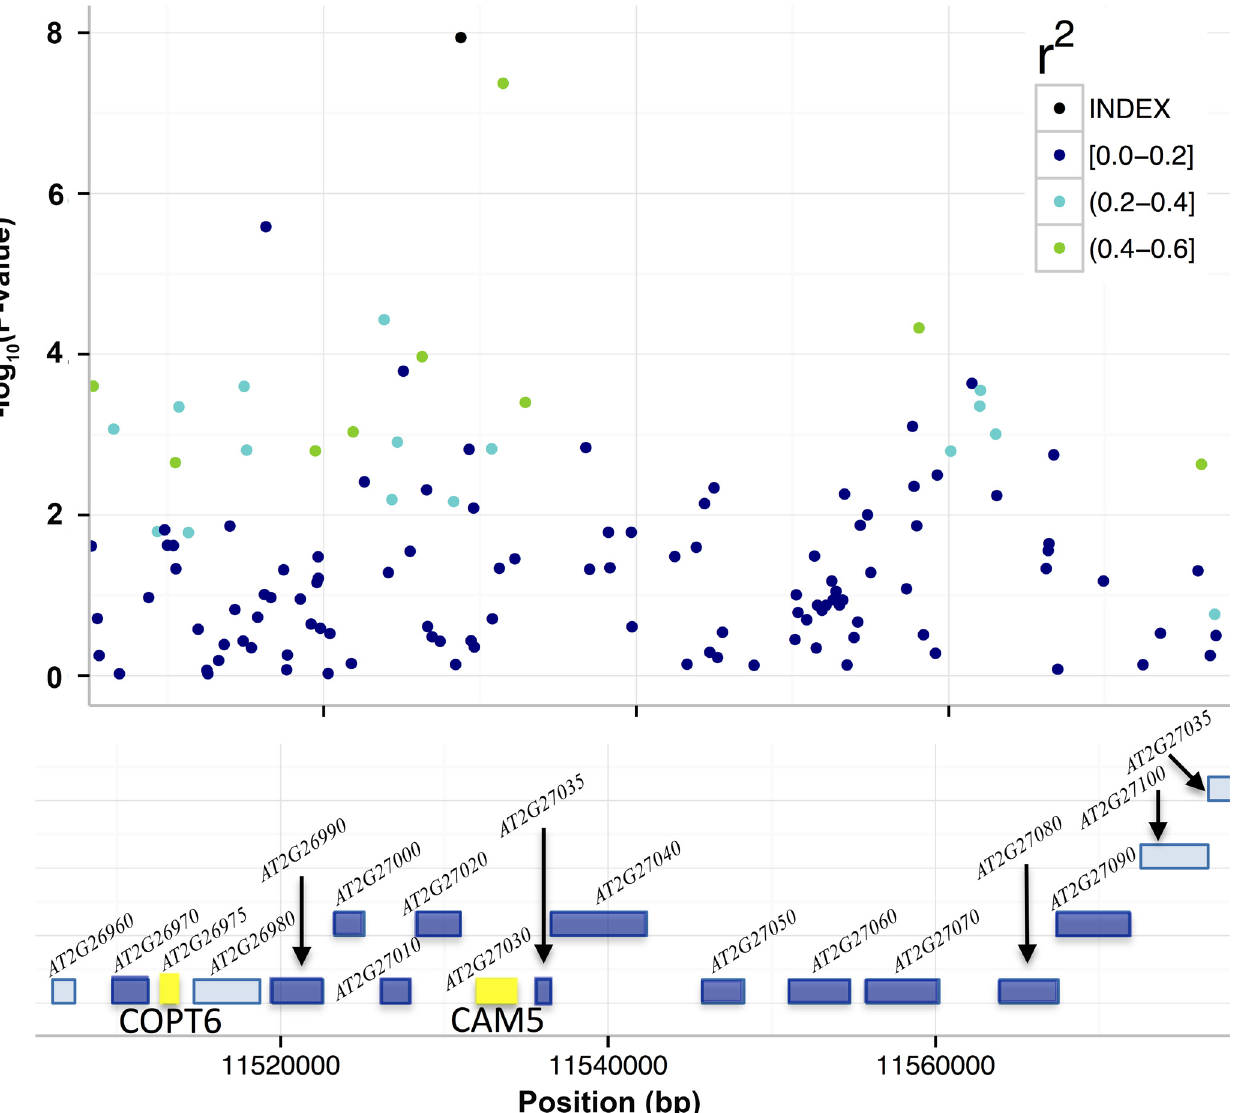
Fig 4. T-DNA analyses to identify candidate genes for the associations to mean leaf molybdenum concentrations. Included in the figure are the genes (colored boxes) in the region surrounding SNP 2 that were bounded by the furthest up- and downstream SNPs with r 2 > 0.4. We measured the mean leaf molybdenum concentrations for available T-DNA insertional alleles and compared them to the wild-type Col-0. Yellow box = significant difference in leaf molybdenum concentration, deep blue box = no significant difference, light blue = no T-DNA insertion line tested. The T-DNA lines with insertions in AT2G26975 and between AT2G27020/AT2G27030 had altered mean leaf molybdenum